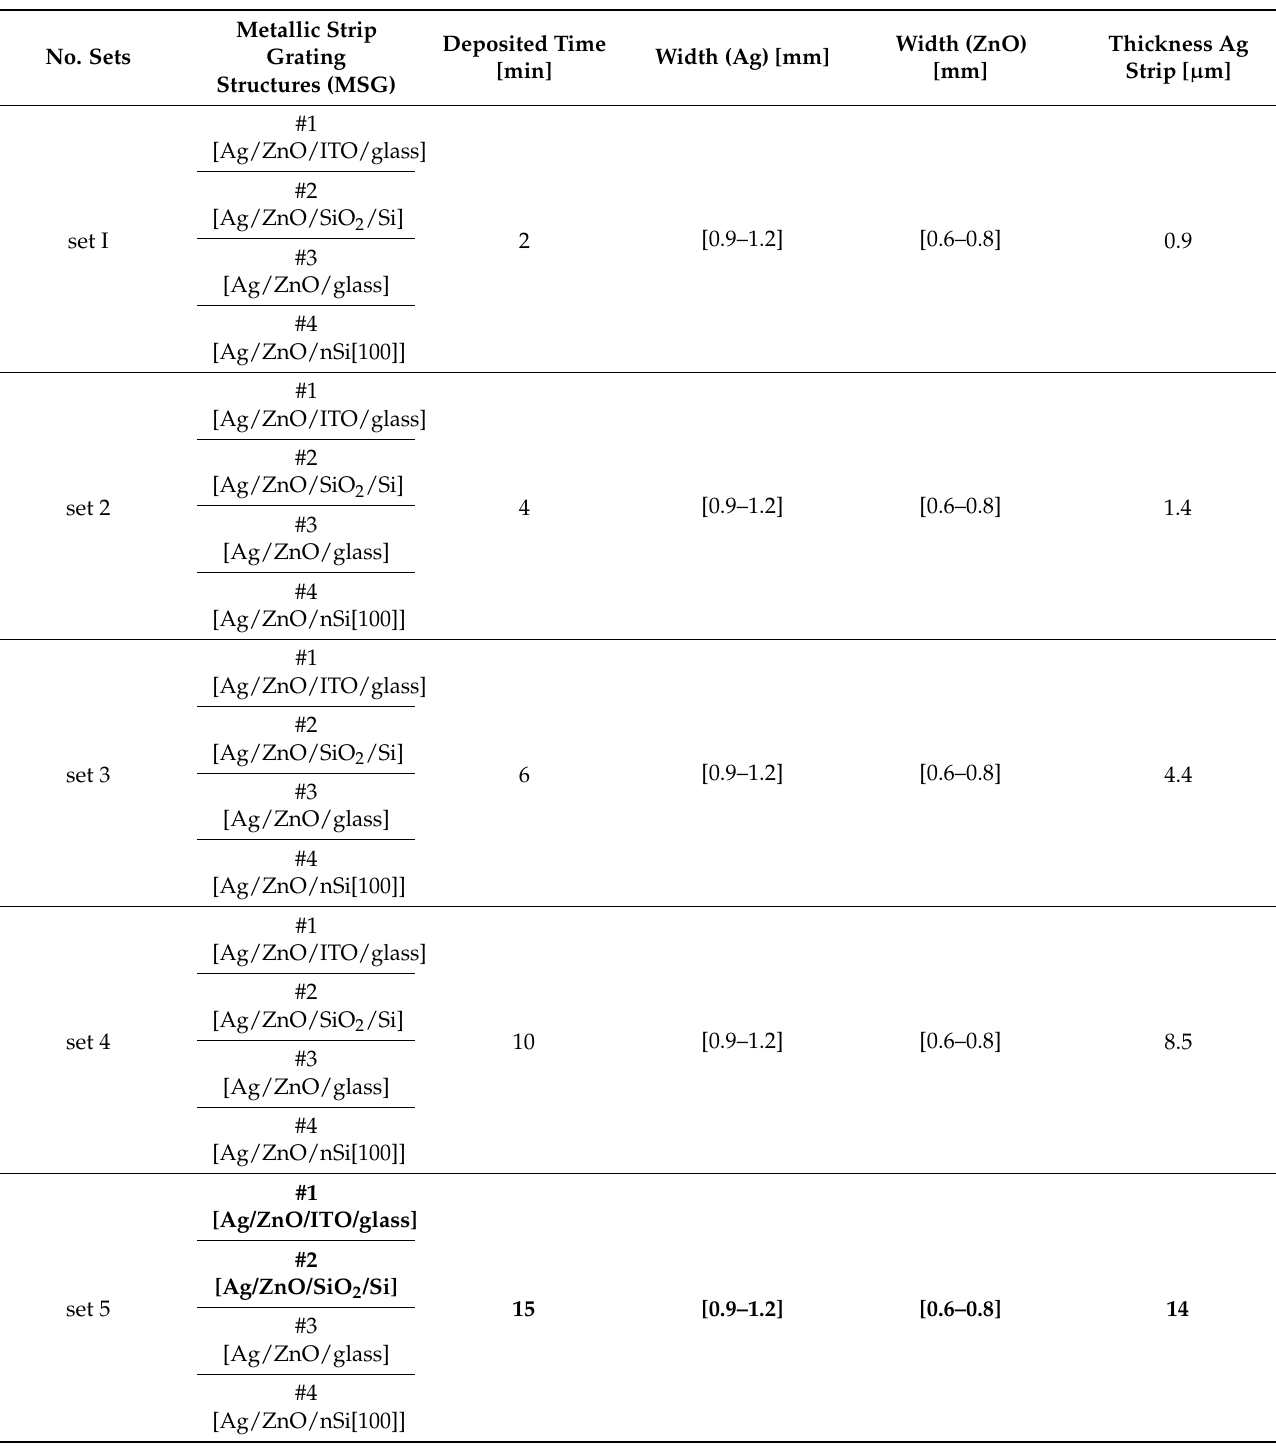
Table 1. The characteristics for the obtained metallic strip grating structures emphasizing the #1 and #2 samples from the set of 5 in the